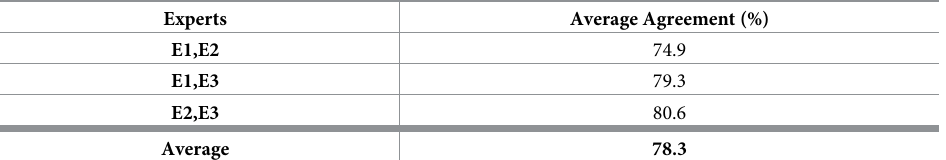
Table 2. Inter-expert scoring